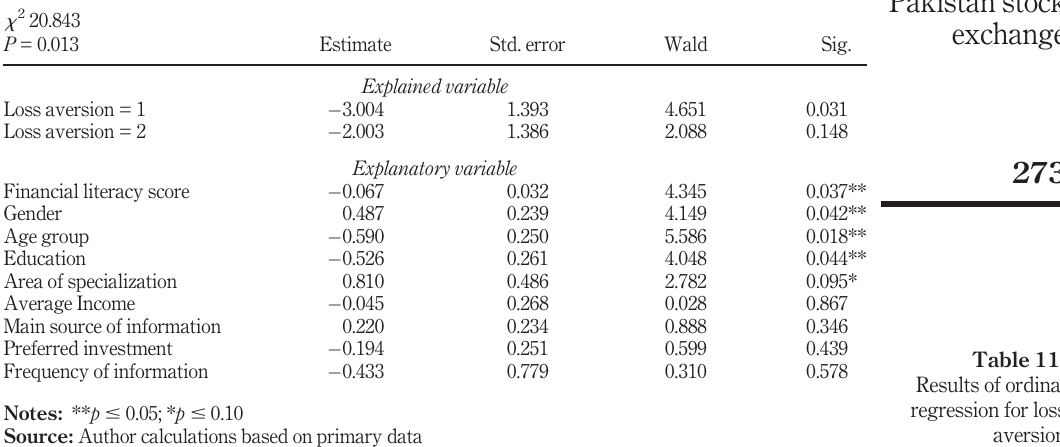
Table 11. Results of ordinal